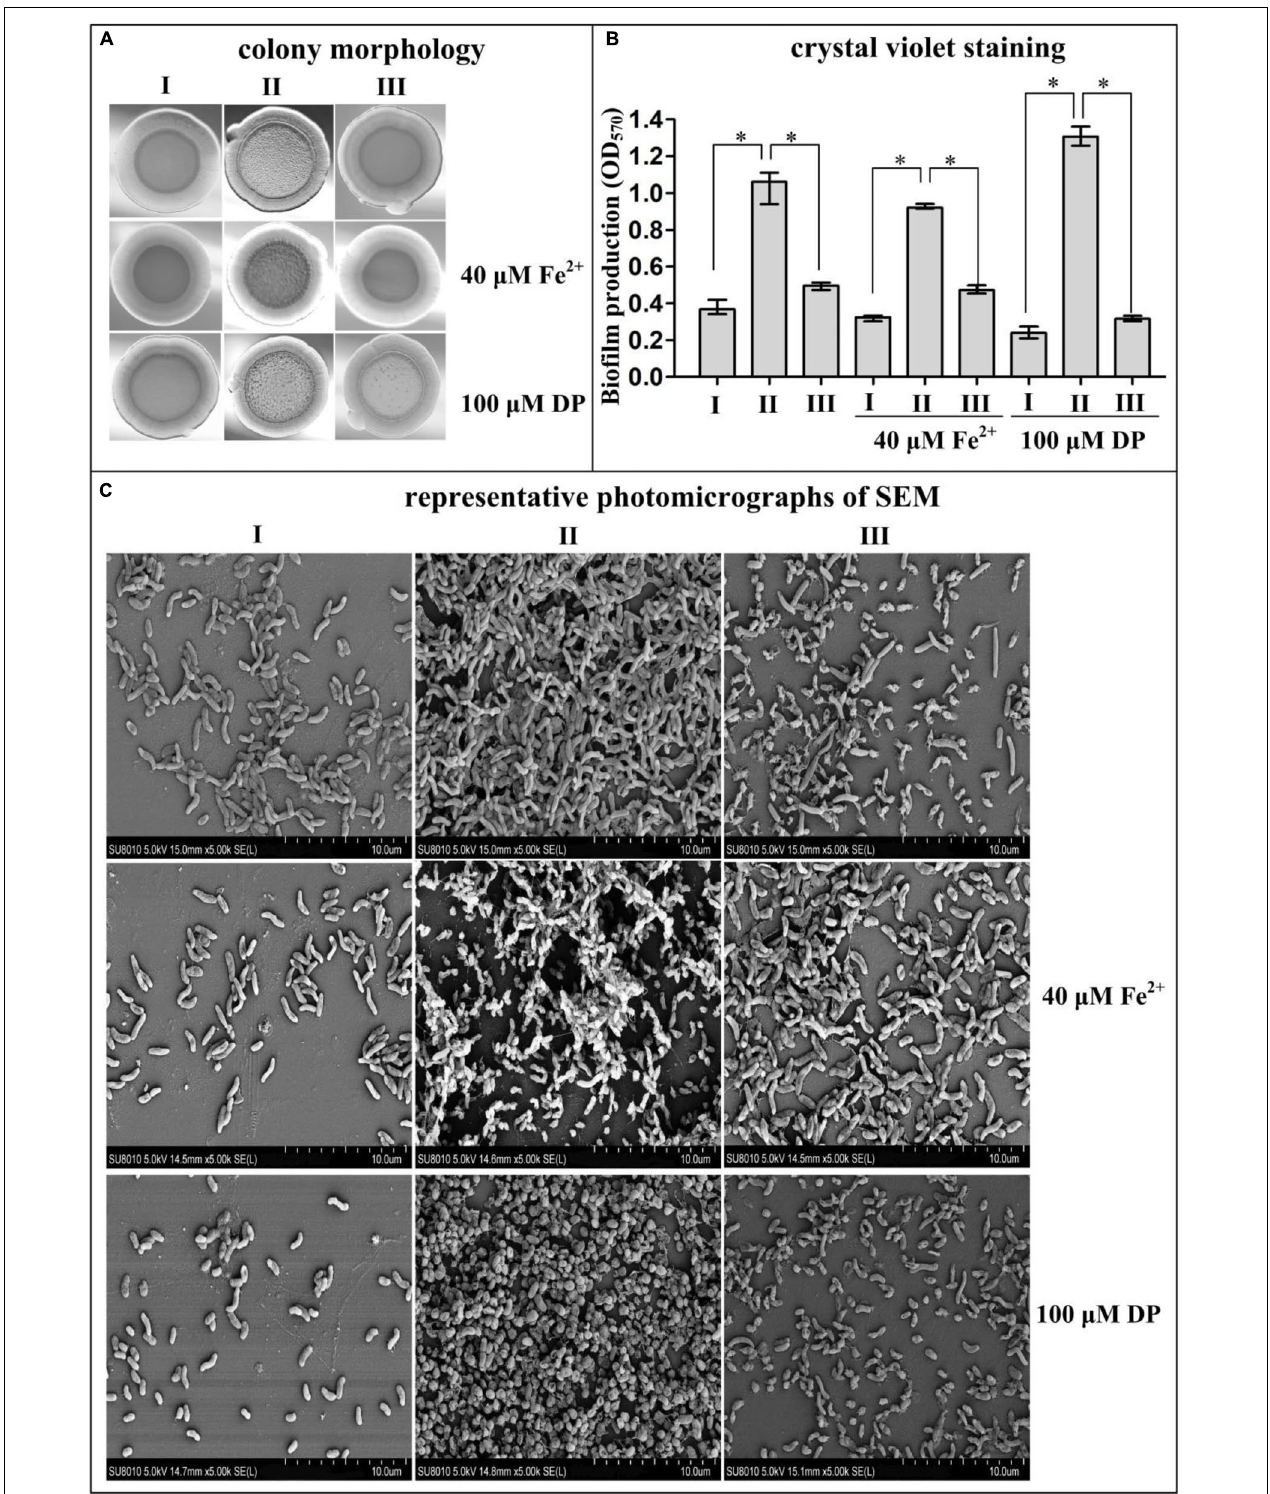
FIGURE 1 | Fur represses biofilm formation by Vibrio cholerae . Biofilm EPS production and biofilm adherence to abiotic surfaces were measured by rugose colony morphology (A) , intensity of crystal violet staining (B) , and photomicrographs of SEM (C) . I, II, and III represent WT/pBAD24, (cid:49) fur /pBAD24, and (cid:49) fur /pBAD24- fur , respectively. Pictures presented in panels (A,C) were representative of three independent experiments with three replicates each. The asterisk (*) represents P < 0.01, which was determined by a two-way ANOVA with Tukey’s post hoc .